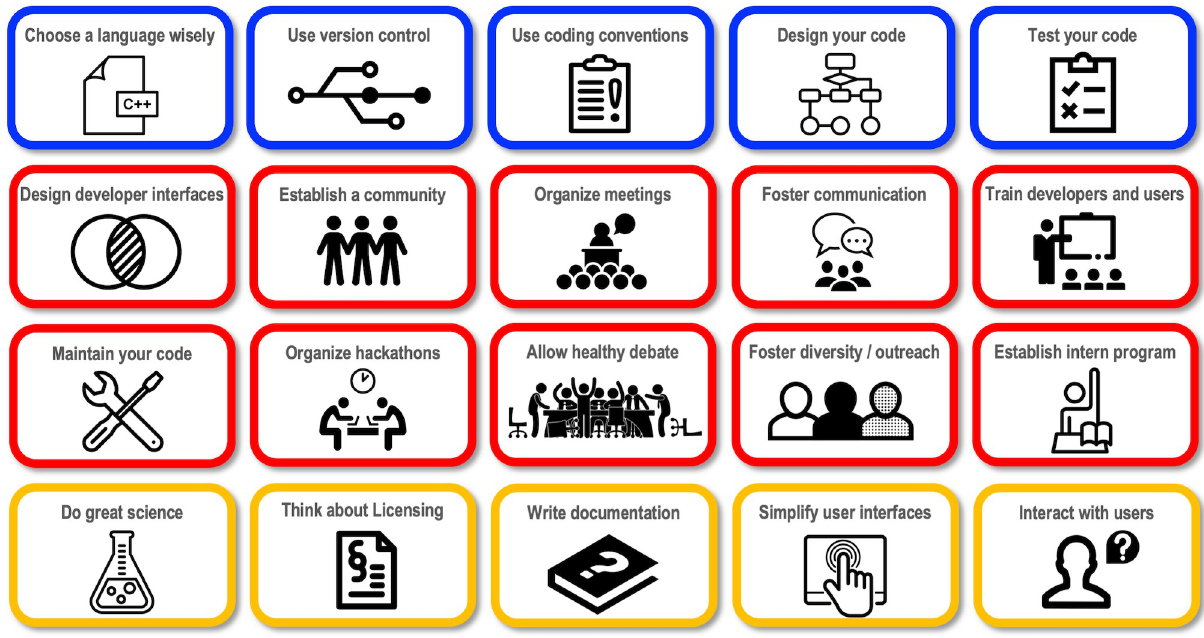
Fig 2. Pillars of success in the development of scientific software. Technical aspects are in blue, social aspects in red and dissemination and user interaction in yellow. This figure was created with icons from The Noun Project[13].